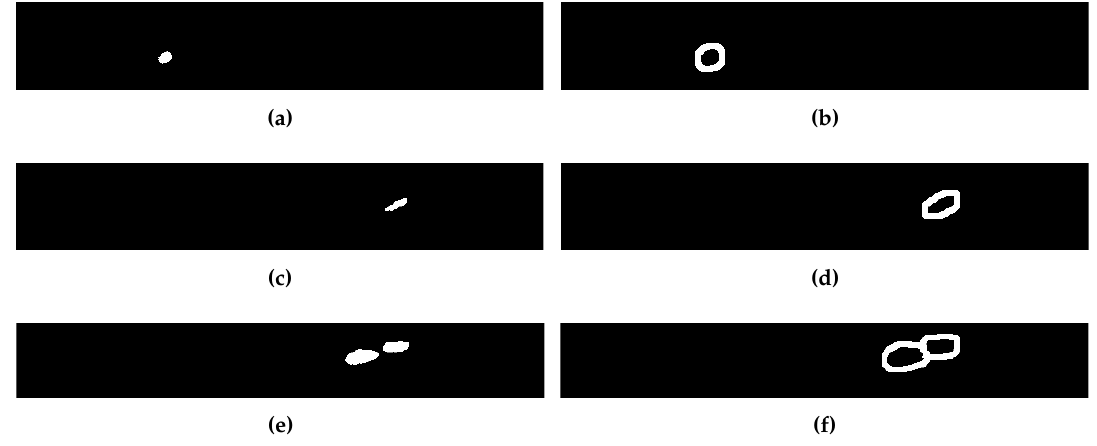
Figure 12. Defect and sound regions for defects with impact damage of 3, 6 and 9J. ( a ) Defect region for 3J impact. ( b ) Sound region for 3J impact. ( c ) Defect region for 6J impact. ( d ) Sound region for 3J impact. ( e ) Defect region for 9J impact. ( f ) Sound region for 9J impact.